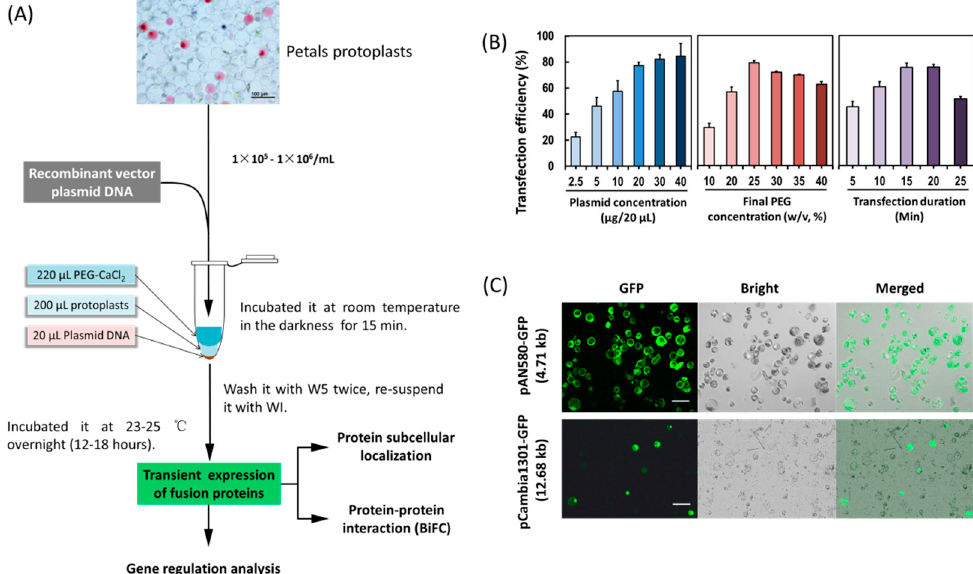
Figure 2. Establishment of an e ffi cient protoplast-based transient expression system (PTES) for Cymbidium orchids. ( A ) Schematic illustration of protoplast transfection and application of the PTES; ( B ) factors a ff ecting the PEG-mediated protoplast transfection, including incubation time, final PEG4000 concentrations and plasmid DNA amount were optimized and ( C ) the green fluorescence of the green fluorescent protein (GFP) reporter expressed by the two vectors was clearly visible. The maximum transfection e ffi ciency of PAN-580 (4.71 kb in size) and pCambia1301-GFP (12.68 kb) were 80% and 30%, respectively. Data presented as means of three biological replicates with error bars indicating the SD. Bar = 100 µ